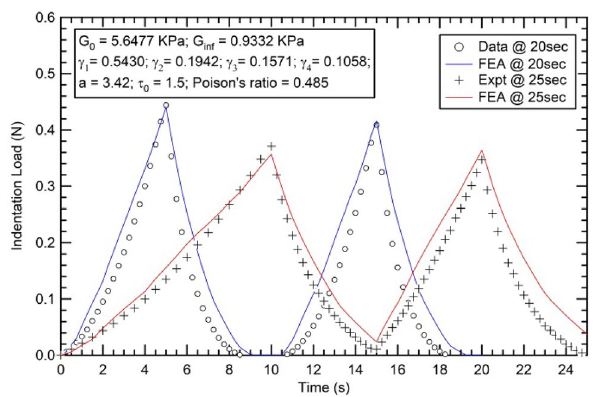
Fig. 9 Fit of multi-cycle data with optimized material properties from initial test